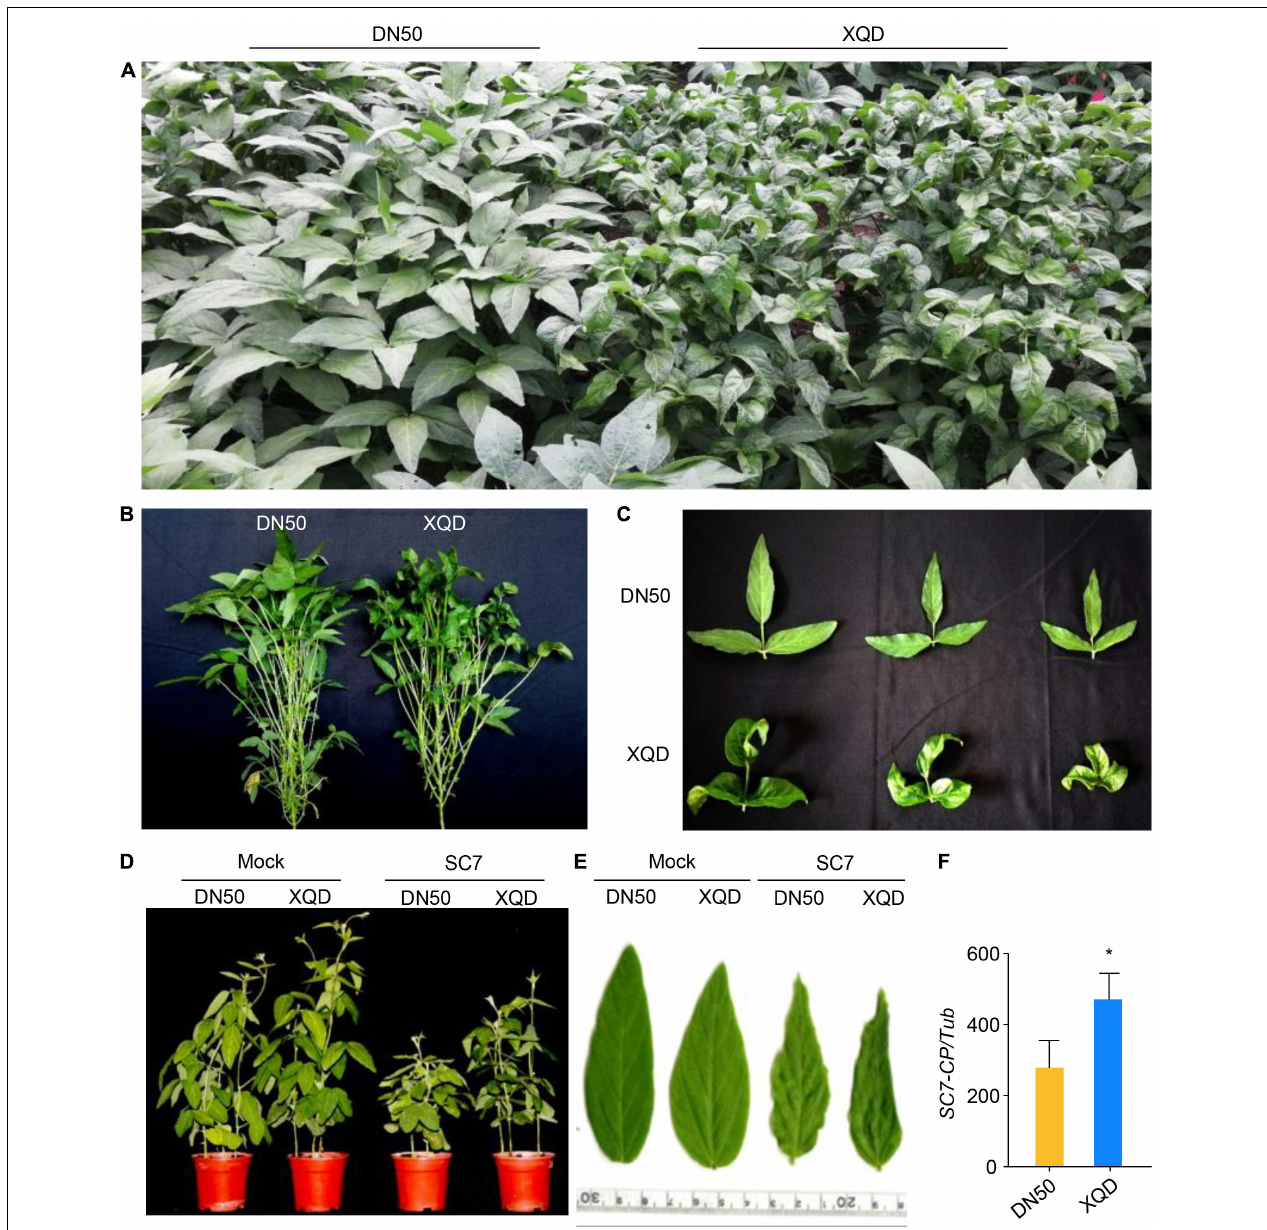
FIGURE 1 | Phenotypes of two soybean cultivars, DN50 and XQD, inoculated with soybean mosaic virus strain SC7. (A,B) Phenotype of DN50 and XQD inoculated with SMV in the field. (C) Leaf phenotypes. DN50 shows partial resistance, whereas XQD is susceptible. (D) Phenotype of DN50 and XQD inoculated with SC7 in greenhouse. (E) Leaf phenotype. (F) Accumulation of SC7 in DN50 and XQD SC7-inoculated leaves. The amplification of soybean TUB ( GmTubulin ) was used as an internal control to normalize all data. Data from three biological replicates are shown, each with three technical replicates. Statistically significant differences were determined using Student’s t -test (* P < 0.05). Error bars indicate standard error of the